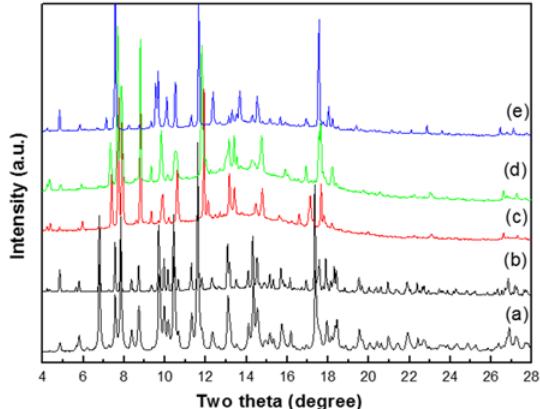
Figure 5. PXRD patterns of ( a ) simulation of 1 from single-crystal X-ray diffraction data; ( b ) fresh samples of 1 at RT; ( c ) De-hydrated samples of 1 at 240 °C; ( d ) the de-hydrated samples 1 exposed to the air at RT; ( e ) the re-hydrated samples obtained by the de-hydrated samples 1 immersed in the water solution.